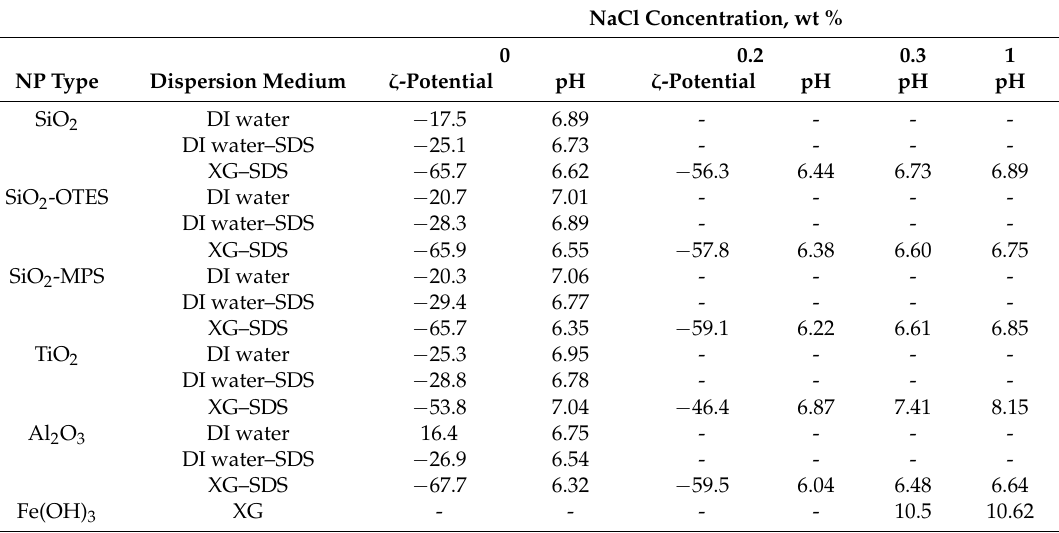
Table 1. ζ -potential and pH values of xanthan gum (XG) nanopolymer sols at 20 ◦